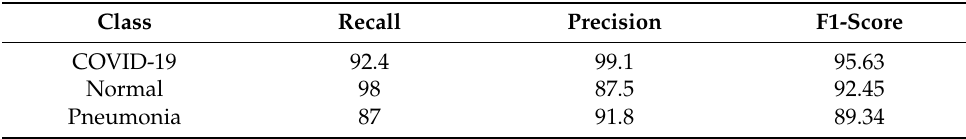
Table 4. Performance metrics of image validation using